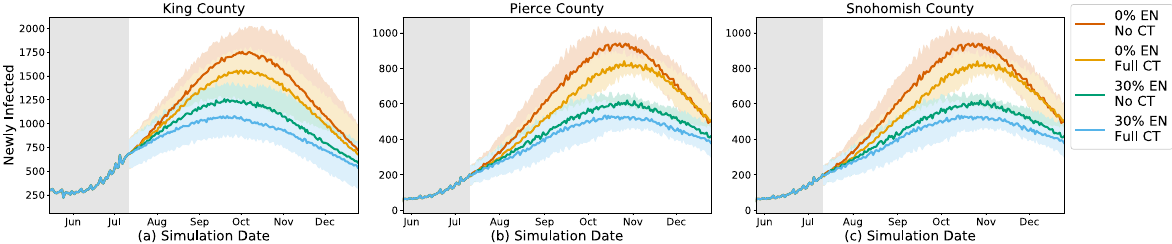
Fig. 5 Combined effects of manual contact tracing and exposure noti fi cation system. Comparison between manual contact tracing (CT) at the recommended staf fi ng level and exposure noti fi cation (EN) at 30% adoption in King ( a ), Pierce ( b ), and Snohomish ( c ) counties. In all three counties, the combined effect is greater than individual contributions by either